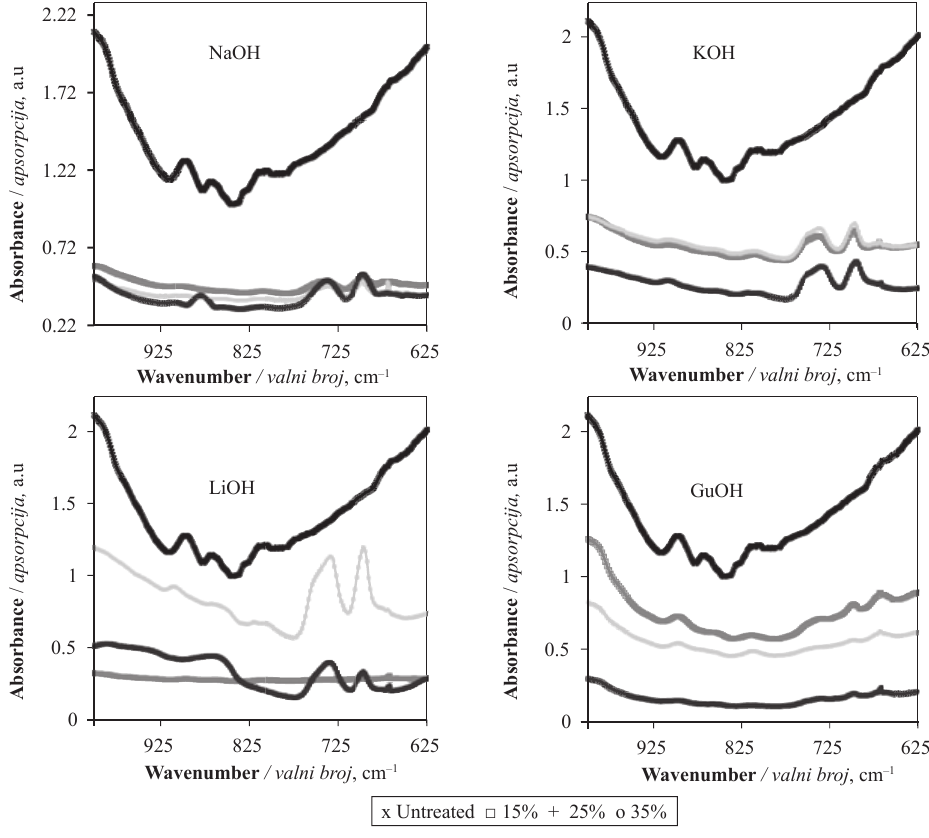
Figure 5 Appearance of bands at 698 cm -1 , 740 cm -1 Slika 5 . Pojava skupina na 698 cm -1 , 740 cm